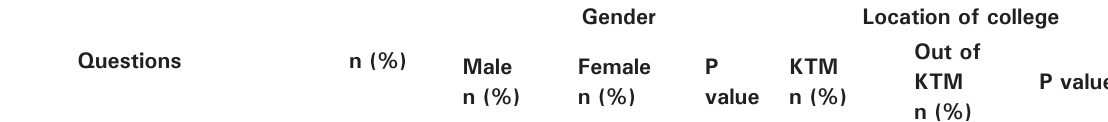
Table 2. Responses to the 4 th , 5 th and 6 th questions and their associations with gender and location of the